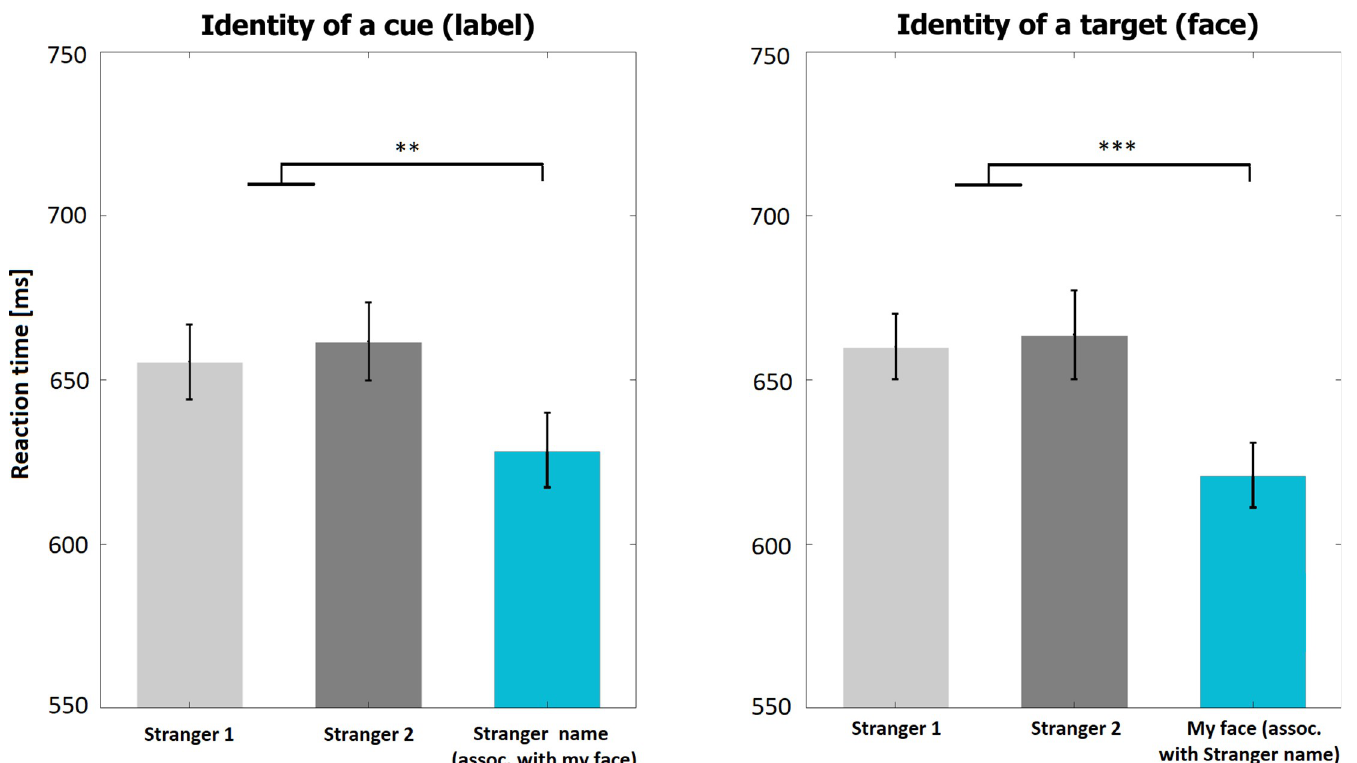
Fig 3. Results of Experiment 2. Blue bar represents average reaction time for condition with participant’s real face which has been associated with a stranger’s identity, and grey bars represent stranger-related conditions. � reflects statistical significance below 0.05, �� below 0.01, and ��� below 0.001.